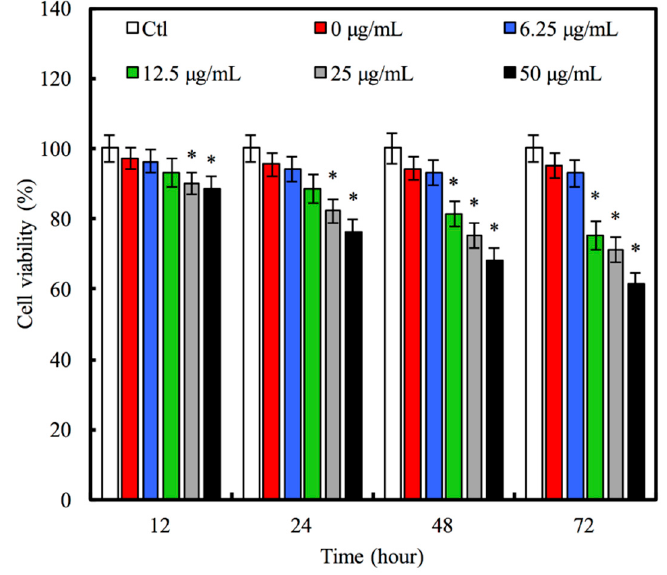
Figure 4. Cell viability of A549 cells after various time-points in culture with 50 μ g/mL MCS nanoparticles loaded different concentration of hinokitiol. Star indicates a significant difference ( p < 0.05) compared to 0 μ